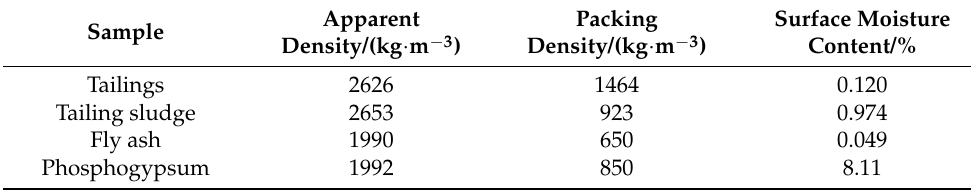
Table 3. Mineral composition of test materials.